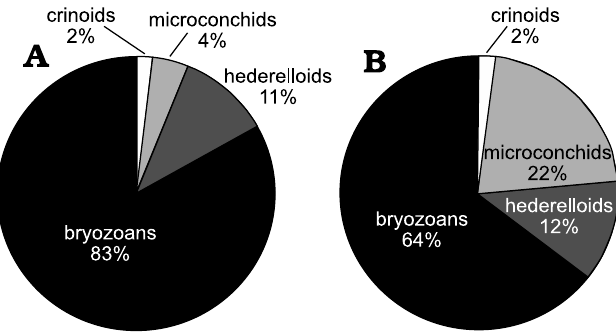
Fig. 5. Percentage of all sclerobiont groups: athyridids ( A ) and rhynchonel- lids ( B ) per brachiopod order.